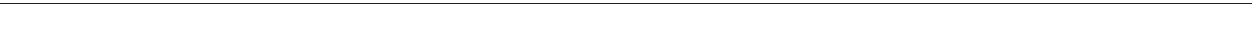
Fig. 7 NDR1 binds to miR146a intergenic region to dampen NF- κ B-mediated miR146a transcription. a Absolute quanti fi cation PCR analysis of pri-miR146a expression in WT and NDR1 − / − immortalized BMDMs. b Real-time PCR analysis of pri-, pre-, and mature-miR146a expression in WT and NDR1 -de fi cient PMs. TaqMan microRNA assay using speci fi c hydrolysis probes for mature miR146a and U6 was performed to achieve speci fi city. c ChIP-qPCR analysis of NF- κ B enrichment in miR146a regulatory sequences with anti-NF- κ B antibody in lysates of WT or NDR1 − / − PMs. d ChIP-qPCR analysis of NF- κ B enrichment in miR146a regulatory sequences with anti-NF- κ B antibody in lysates of NDR1 DNA binding sites de fi cient (NDR1 DBS − / − ) and control (NDR1 DBS + / + ) L929 cells transfected with fl ag-NDR1 or empty vector. e Real-time PCR analysis of mature miR146a expression in NDR1 DBS + / + and NDR1 DBS − / − L929 cells transfected with fl ag-NDR1 or empty vector. f Immunoblot analysis of STAT1 expression in NDR1 DBS + / + and NDR1 DBS − / − L929 cells transfected with fl ag-NDR1 or empty vector. g Immunoblot analysis of STAT1 expression in WT and NDR1 − / − PMs, transfected with miR146a inhibitor or negative control. h Immunoblot analysis of STAT1 in lysates of L929 cells stably overexpressing pre-miR146a or empty vector, transfected with plasmids expressing fl ag-NDR1 or fl ag-none. i Real-time PCR analysis of VSV-G mRNA in L929 cells stably overexpressing pre-miR146a or empty vector, speci fi c or scrambled siRNA for 48 h. k FACS analysis of virus replication in WT and miR146a − / − L929 cells treated as in j , followed by VSV-eGFP infection. l Immunoblot analysis of STAT1/IRAK1/TRAF6 expression in the lysates of WT and NDR1 − / − PMs. m Immunoblot analysis of